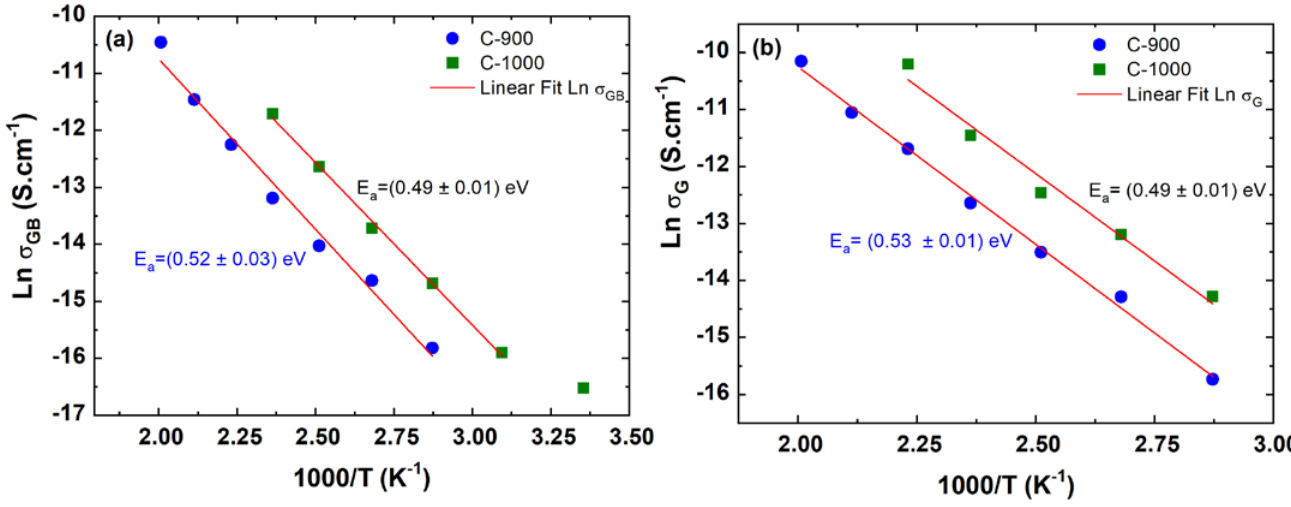
Figure 9. Arrhenius plots of the grain interior and grain boundary conductivities for FeSbO 4 ceramics (C-900 and C-1000) for regions: ( a ) grain boundary; ( b ) grain.